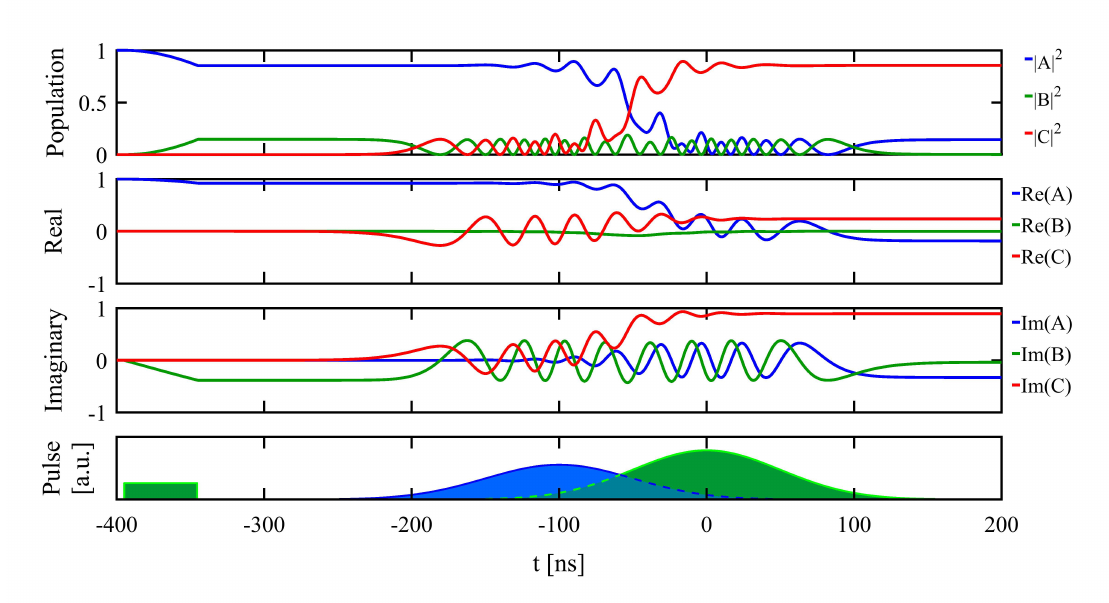
Figure 2. Time evolution of the system. The upper panels show the populations of the three states | A | 2 , | B | 2 , and | C | 2 , as well as real and imaginary parts of the the wavefunction amplitudes during the hybrid STIRAP sequence. The pulses driving the sequence are shown in the lowest panel. The simulation is performed with the parameters φ 01 = π /3, φ 12 = π /4, Ω α = cos ( π /8 ) , and β = − i sin ( π /8 )